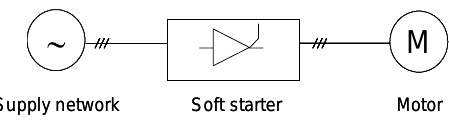
Fig. 11. Simplified scheme for the test.